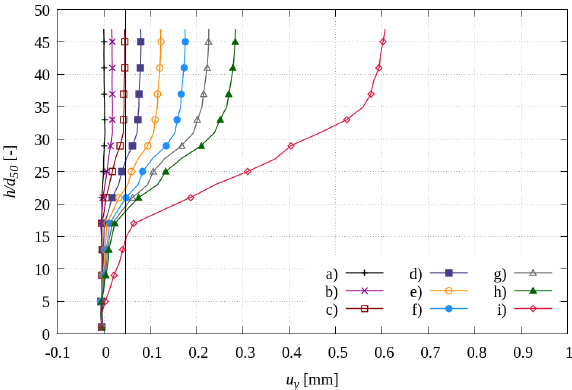
across the y at the specimen centre for: a) u 50 x = 0.50 mm, c) u = 0.75 mm, d) u = 1.00 mm, e) u x x x x = 1.50 mm, g) u = 1.75 mm, h) u = 2.00 mm and i) x x x = 0.60, σ = 200 kPa, d = 0.5 mm) (dark vertical 0 0 50